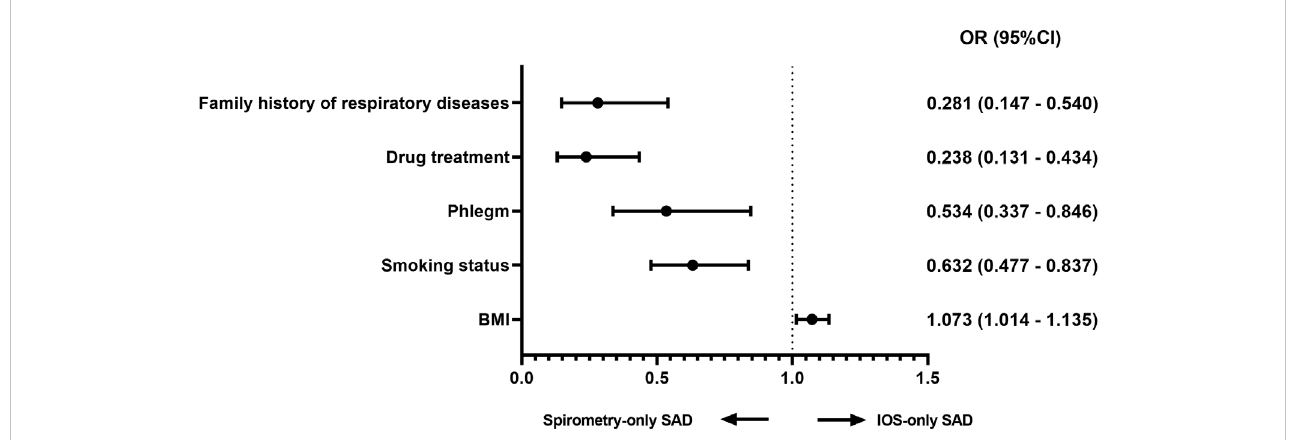
FIGURE 1 Factorsassociatedwithdiscordance(multivariablelogisticregression)adjustedanalysiscomparingIOS-onlySADandspirometry-onlySADinallsubjects adjusted for age, sex, BMI, smoking status, and smoking index. Abbreviations: OR, odds ratio; BMI, body mass